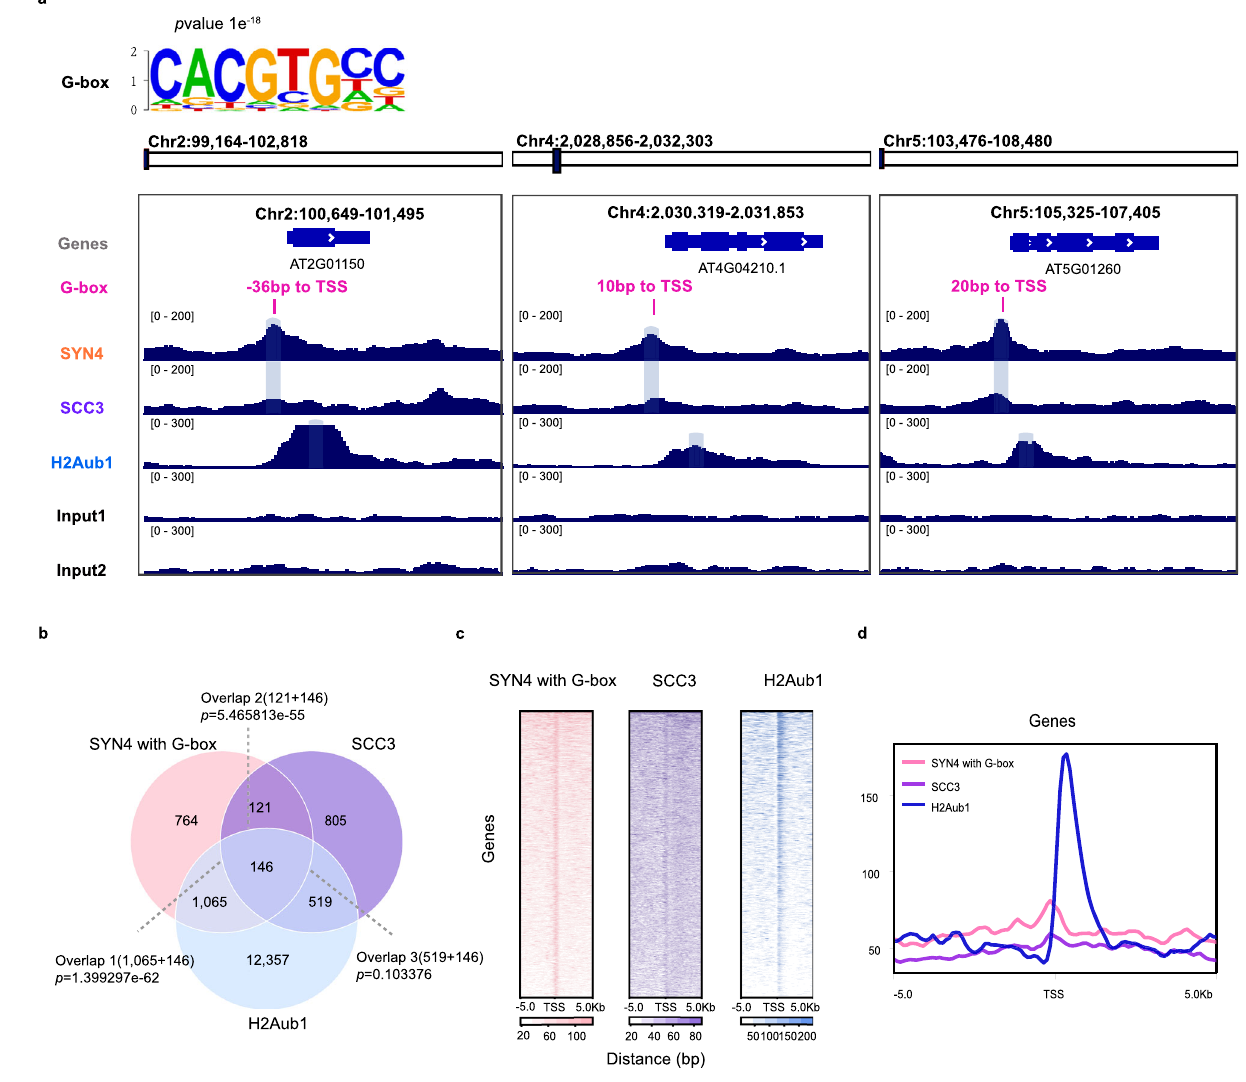
Fig.5|AtSYN4affectsH2Aub1inG-box-containingDNAsequences.a TheG-box motif feature in AtSYN4, AtSCC3, and H2Aub1 binding sites. IGV screenshots of AtSYN4, AtSCC3, and H2Aub1 showing AtSYN4/AtSCC3 peaks occupy the G-box sites of selected genes and locate close to H2Aub1 around TSSs. Three genes